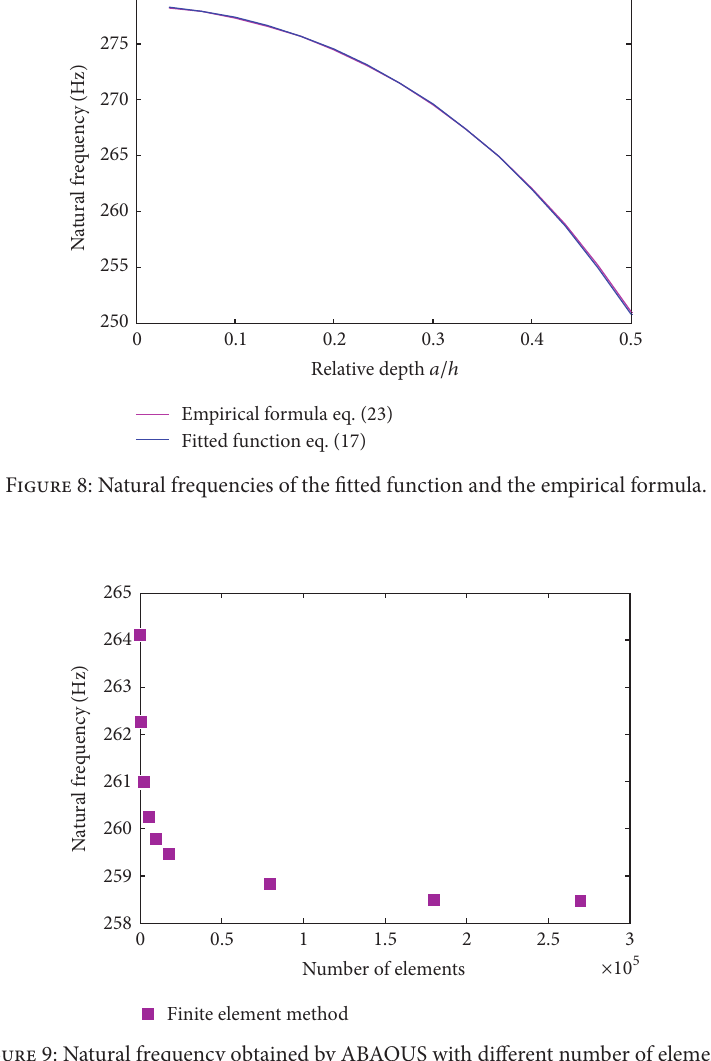
Figure 9: Natural frequency obtained by ABAQUS with different number of